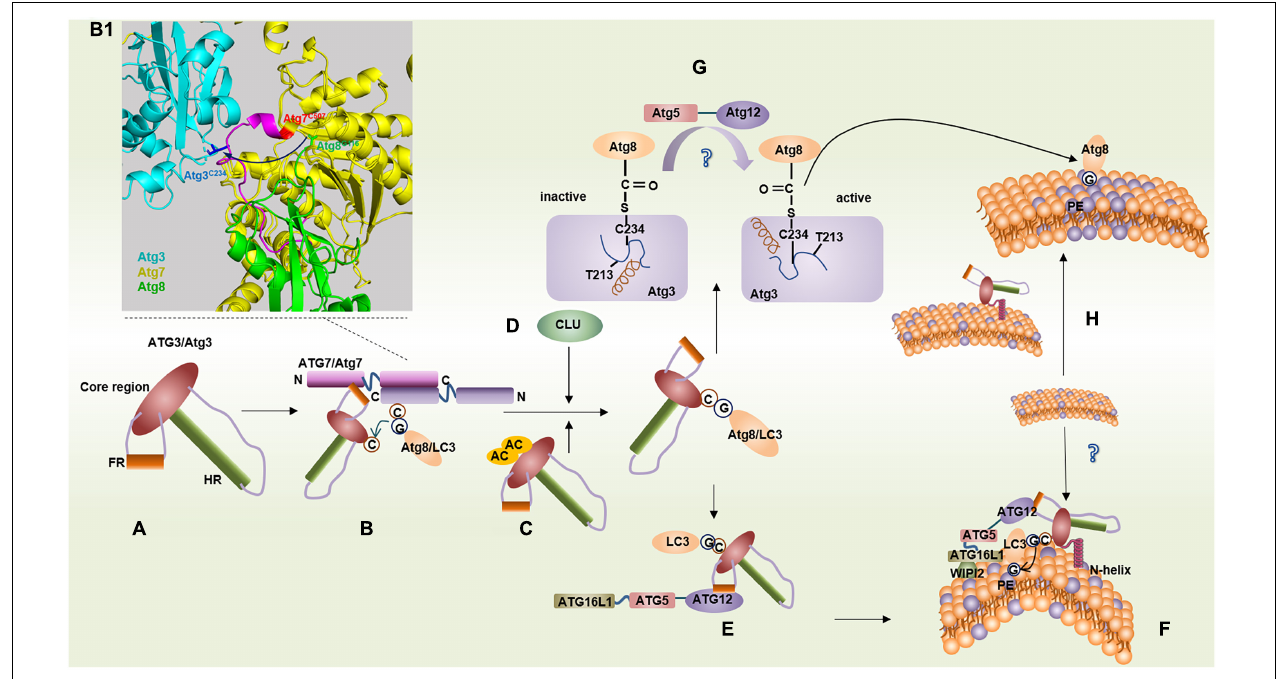
FIGURE 1 | Binding features of ATG3/Atg3 in two conjugation systems. (A) Structure of ATG3/Atg3. (B) LC3/Atg8 transfers from ATG7/Atg7 onto ATG3/Atg3 via a transmechanism. (B1) Model representation of the Atg7 ∼ Atg3 ∼ Atg8 complex by aligning Atg7–Atg3 (PDB ID: 4GSL) with the Atg7 CTD –Atg8 (PDB ID: 3RUI). Atg8 G 116 transfers from Atg7 C 507 to Atg3 C 234 , where Atg3 binds with another Atg7 within an Atg7 dimer. (C) Acetylation of K19 and K48 of Atg3 promotes Atg3–Atg8 conjugate. (D) Molecular chaperone clusterin (CLU) promotes ATG3-LC3 heterocomplex stability. (E) ATG3 FR binds with ATG12 conjugate facilitating LC3 lipidation. (F) ATG3 N-helix inserts highly curved membrane mediating LC3 lipidation. (G) In yeast, the interaction between the loop (blue) containing the catalytic Cys234 and helix G (brown) in Atg3 makes Cys234 face away from Thr213, which suppresses Atg3 conjugase activity. Atg12–Atg5 leads to the reorientation of Cys234 by some unknown means, and then Cys234 faces to Thr213 to facilitate the Atg8 lipidation. (H) N-terminal domain of Atg3 can increase local PE density on the